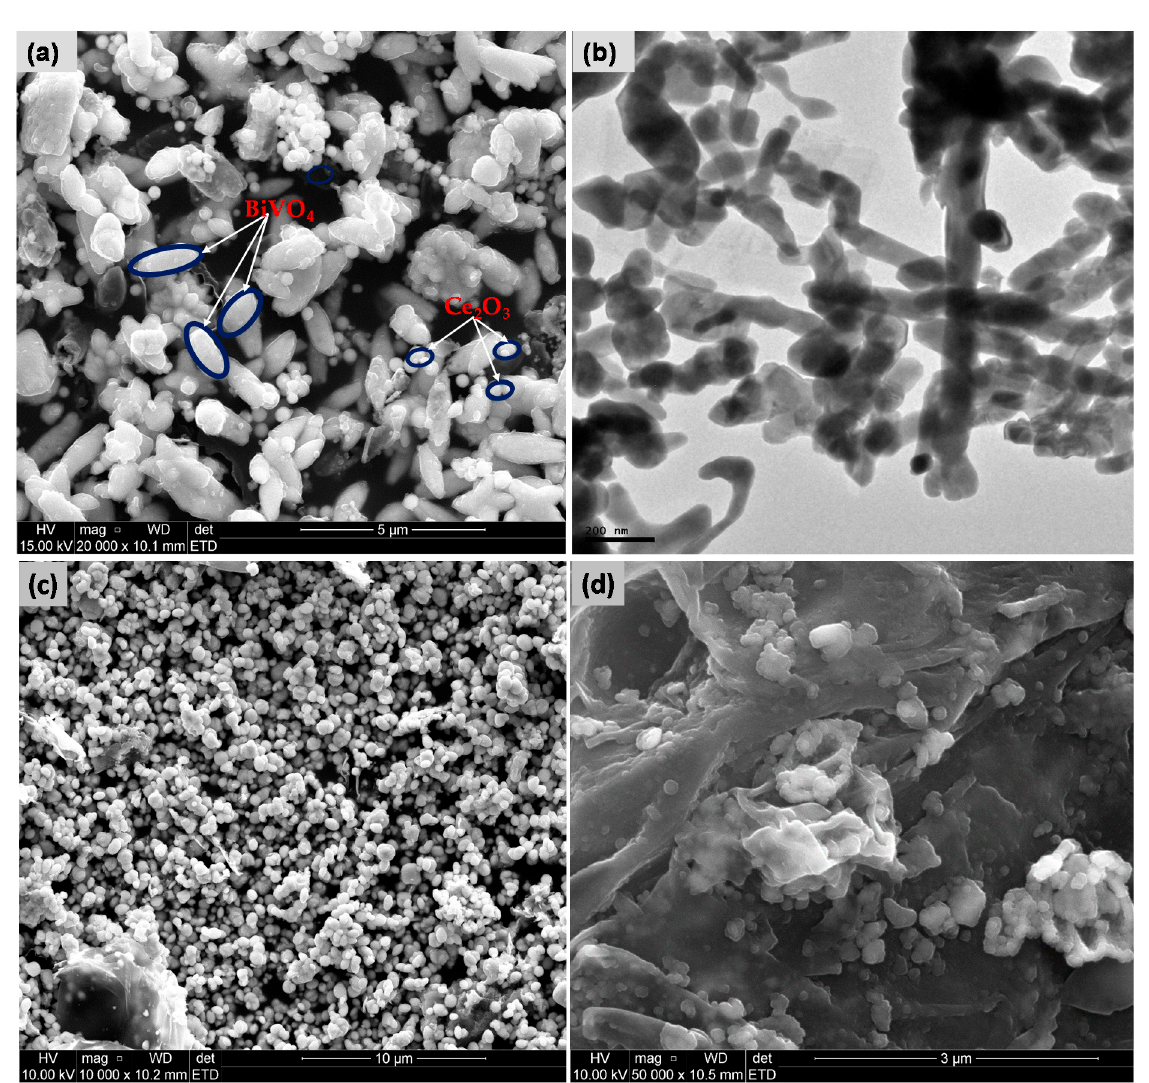
Figure 3. ( a ) SEM and ( b ) TEM micrographs of Ce 2 O 3 /BiVO 4 ; and ( c ) SEM and ( d ) TEM micrographs of Ce 2 O 3 /BiVO 4 incorporated into rGO.